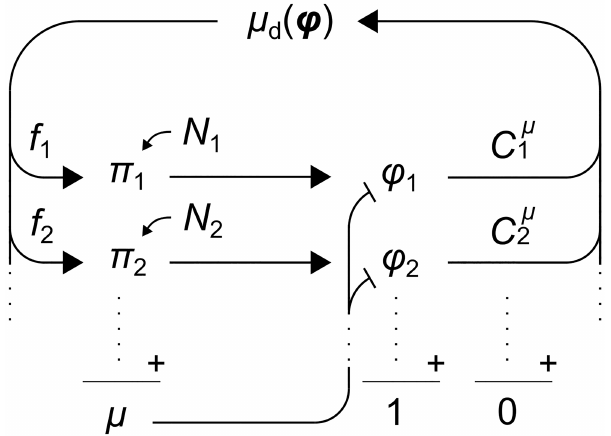
Fig 1. Integrated model of stochastic gene expression and cell growth. The cell contains many protein species, with proteome mass fractions ϕ i that sum to 1. Mass fractions are increased by protein synthesis but diluted by growth. The synthesis rate π of each species i is modulated by a noise source N . The instantaneous growth rate μ reflects the total i i rate of protein synthesis. Proteins affect metabolism and thus the deterministic growth rate μ d ( ϕ ), as quantified by growth-control coefficients C μ . A fraction f of the total metabolic flux is allotted to the synthesis of protein i . The i i inherent noise in the expression of each gene reverberates through the cell, affecting cell growth and the expression of every other